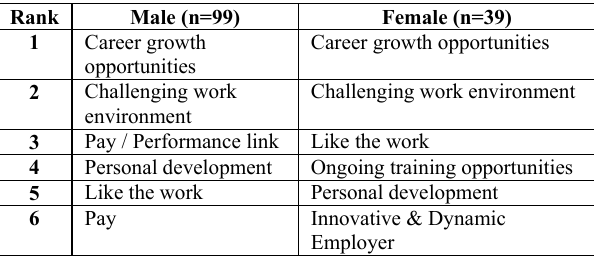
Table 6: The top six attributes for the two gender